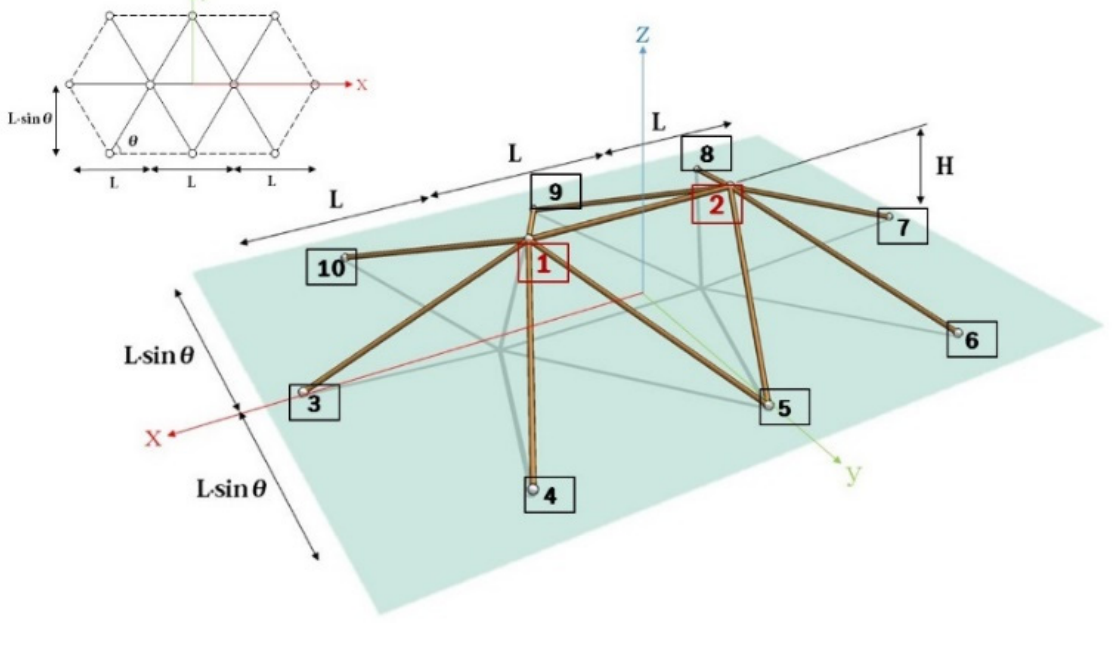
Figure 10. Shape of DFN